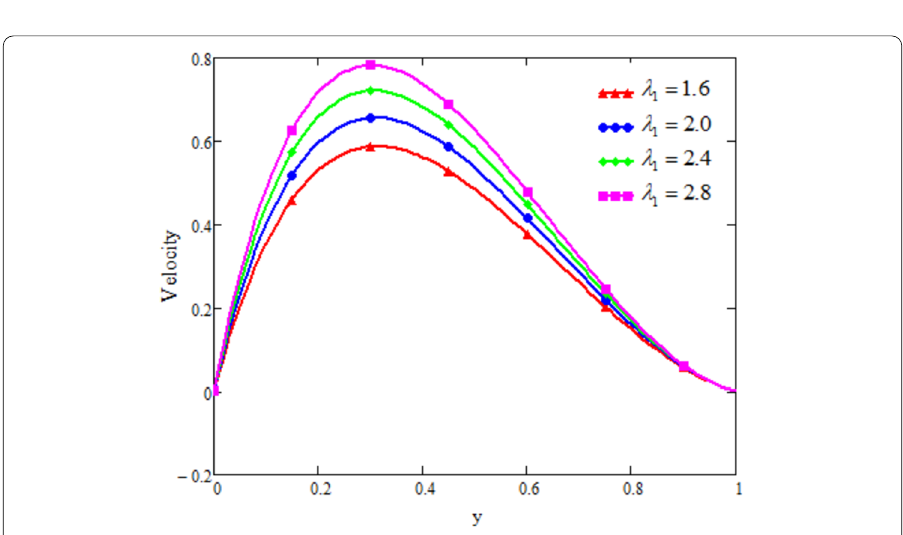
Figure 11 Velocity curves along λ 1 variation and α = 0.5, P r = 11.5, G r = 4.5, K = 1.5, λ = 0.4, H a = 0.6, t =